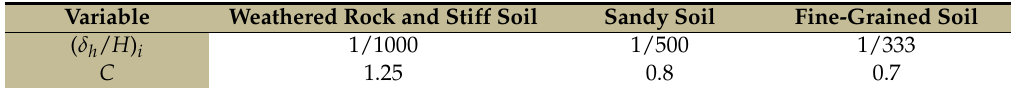
Table 1. The values of ( δ h / H ) i and C coefficients as functions of soil type [19].